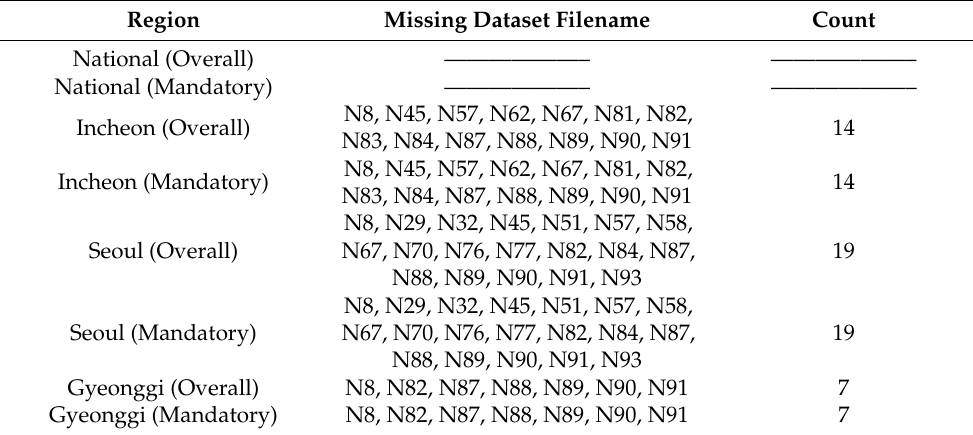
Table 2. List of filenames that do not contain data for National and Greater Seoul regions.